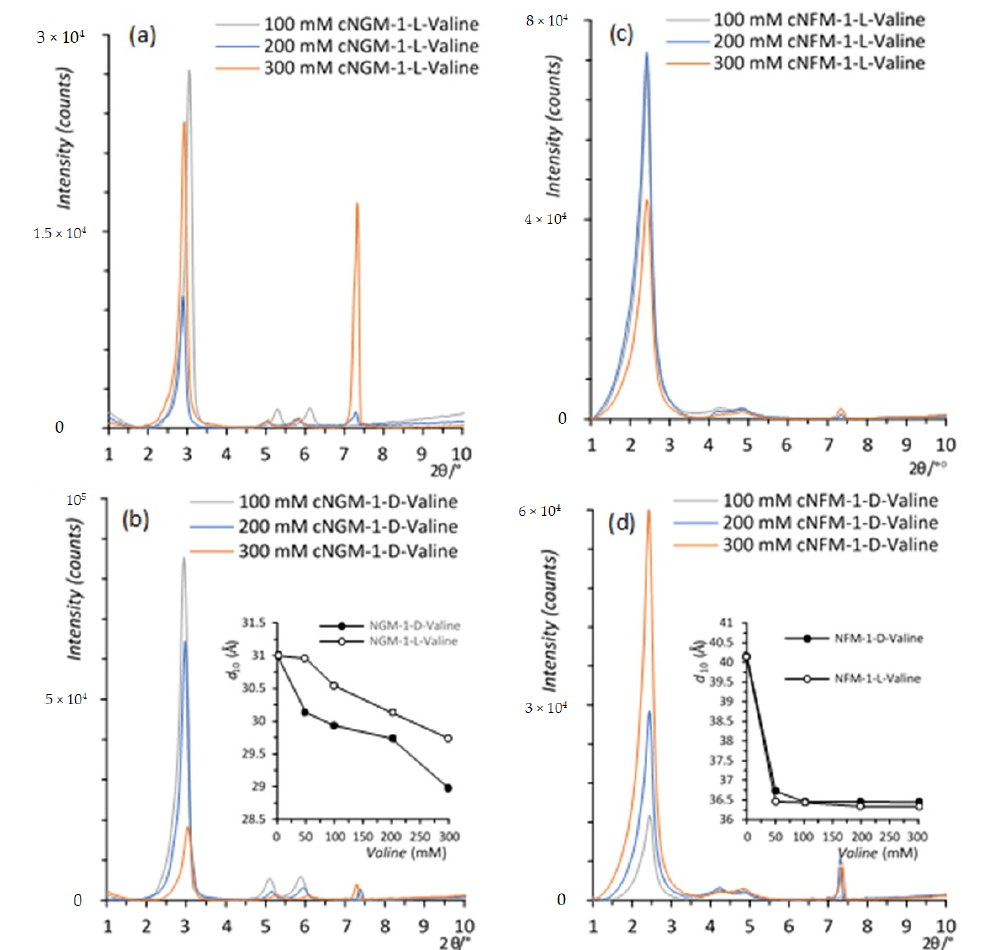
Figure 1. Powder X-ray diffraction patterns of mesoporous samples filtered after adsorption experi- ments, calcined nanoporous guanosine monophosphate material-1 ( c NGM-1) in L -valine ( a ), and D-valine ( b ), calcined nanoporous folic acid material-1 ( c NFM-1) in L -valine ( c ) and D -valine ( d ) at concentrations of 100, 200, and 300 mM. Inset figures in ( b ) and ( d ) show the change in the position of the (10) peak for the adsorption of each